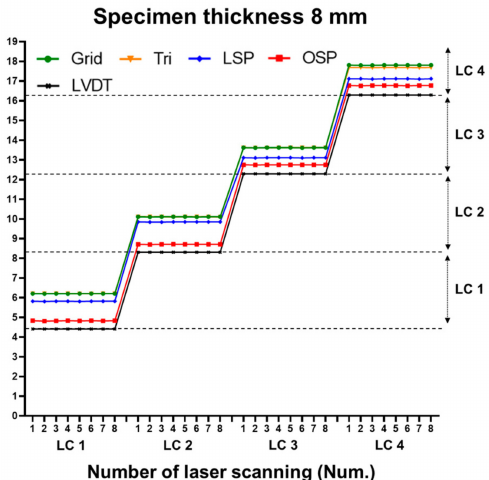
Figure 13. Comparison of vertical displacement with eight repeated laser scans (8 mm specimen).